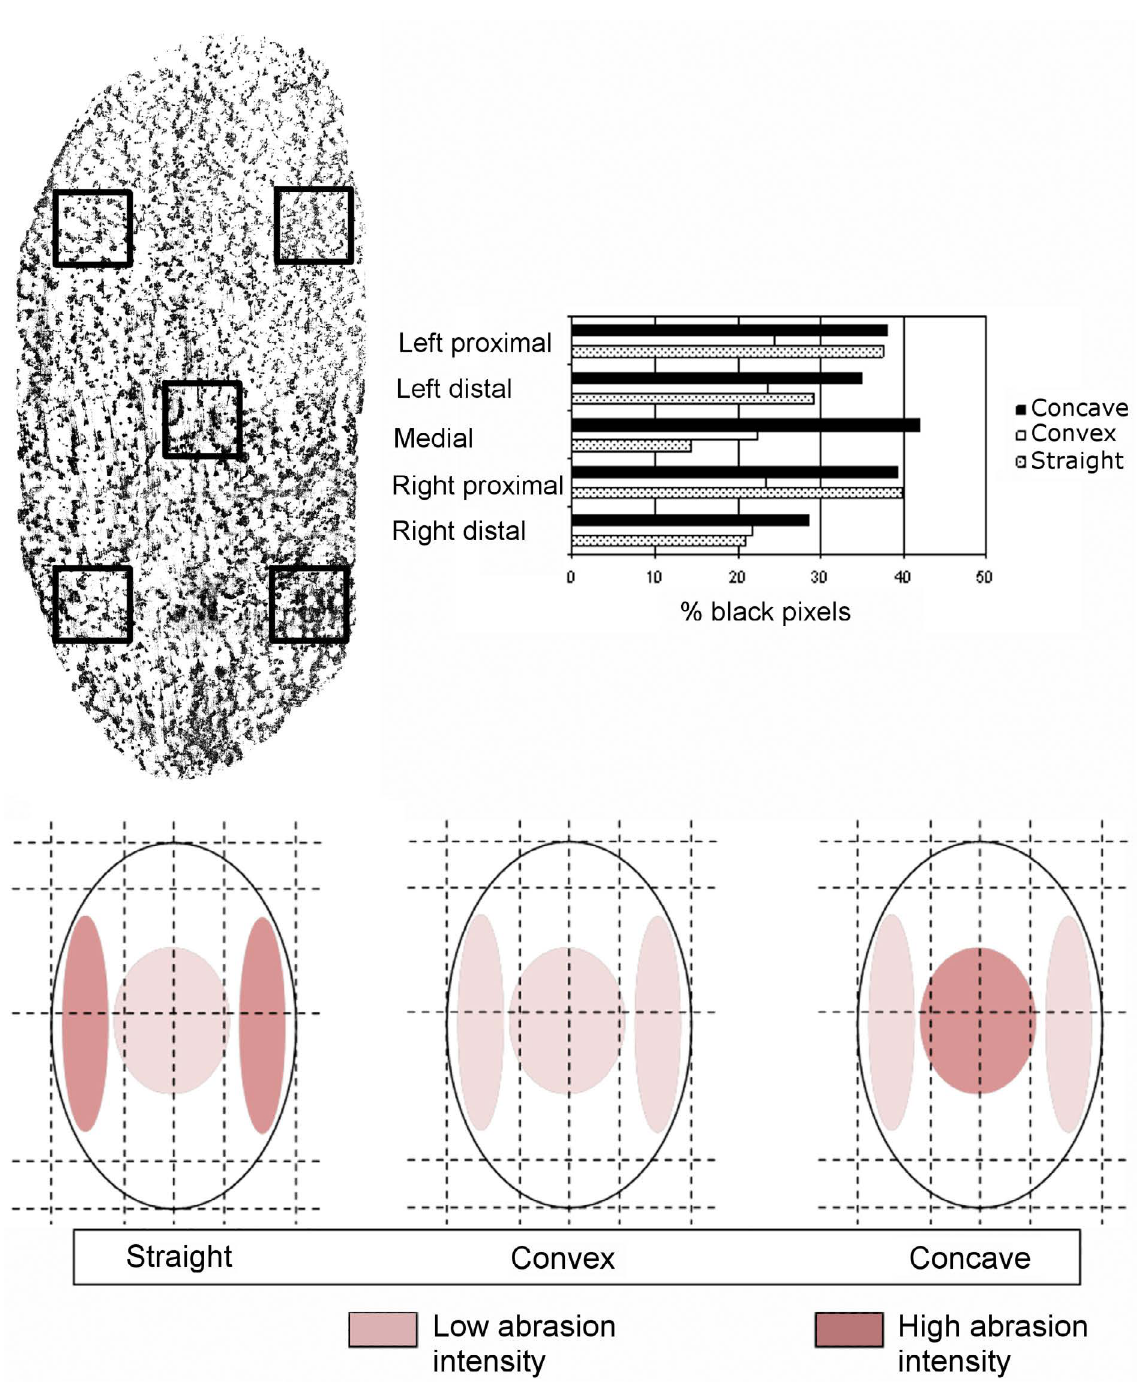
Figure 5. Average percentage of black pixels or levelled topography in the different parts of the active surface of grinding slabs from Guadalentín valley settlements (top); mapping of the abrasive intensity observed on grinding surfaces with different transverse profiles (bottom) (based on Delgado-Raack 2008: fig.